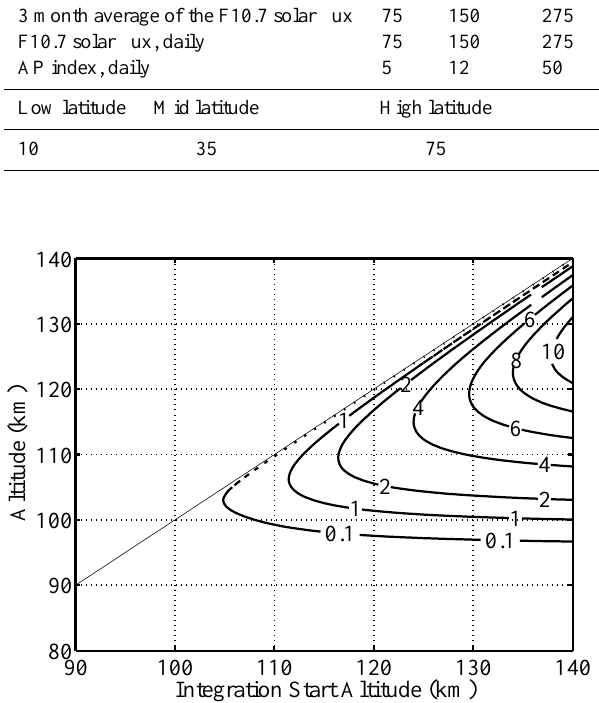
Fig. 3. Contours of temperature bias (K) caused by using the stan- dard Rayleigh lidar retrieval technique applied to measurements simulated using atmospheric composition taken from the MSIS model for mid-latitude, normal solar activity conditions. See Sect. 5 for further details.